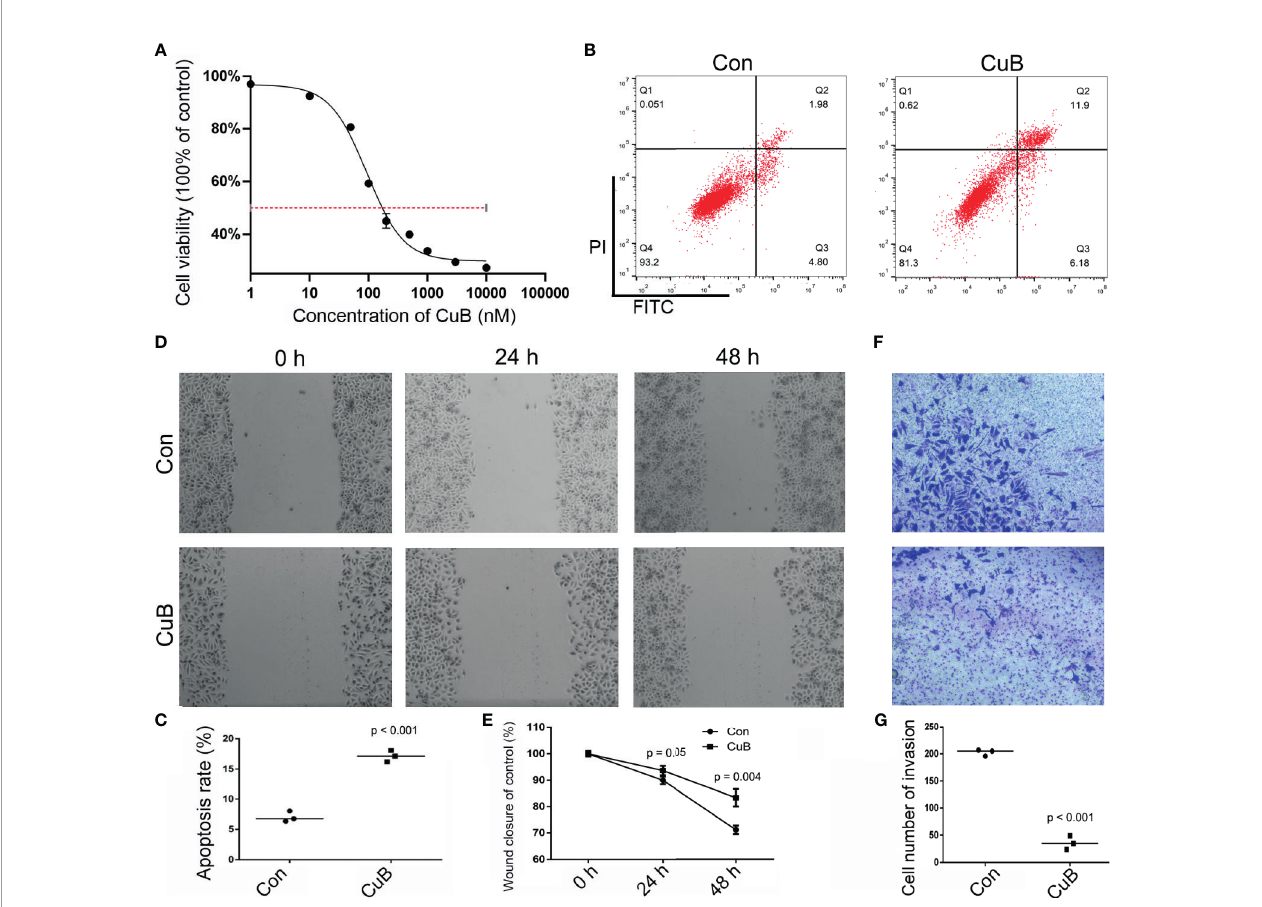
FIGURE 1 | Effects on cell growth, apoptosis, migration, and invasion after CuB treatment. (A) IC50 was assessed in SCC9 cells after CuB treatment to measure the proliferation of SCC9 using CCK8. (B) Cell apoptosis was analyzed in the Con and CuB groups (50 nM) in SCC9 cells to determine the effect of CuB on cell apoptosis. (C) Statistical analysis of the percentage of cell apoptosis among the two groups. (D) Analysis of cell migration in the Con and CuB groups in SCC9 cells to determine the effect of CuB on cell migration. (E) Statistical analysis of the percentage of cell migration between the Con and CuB groups. (F) Analysis of cell invasion in the SCC9 cells to determine the effect of CuB on cell invasion. (G) Statistical analysis of the percentage of cell invasion migration between the Con and CuB groups. Statistical signi fi cances between groups were evaluated using t-test for independent